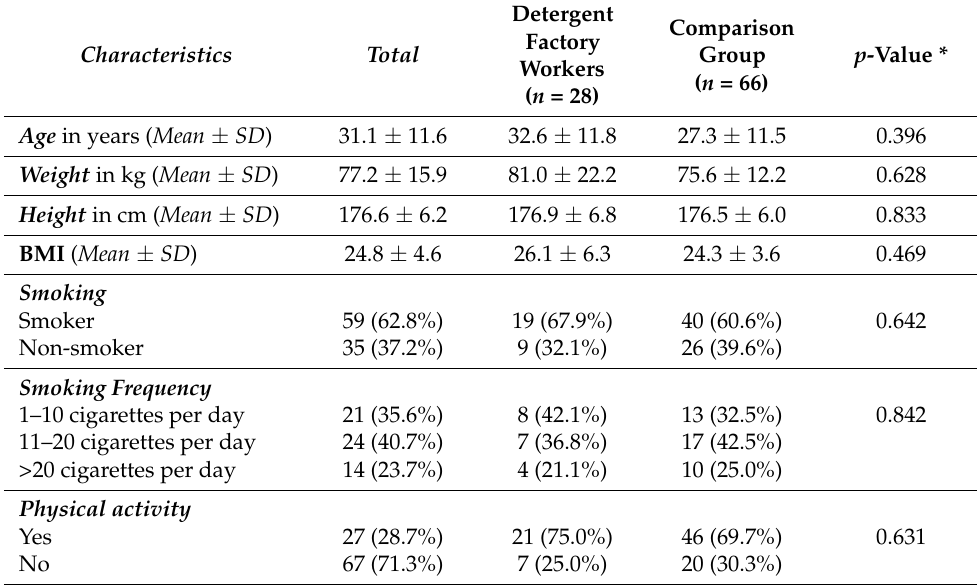
Table 1. Baseline characteristics of the participants ( n = 94). Characteristics Total